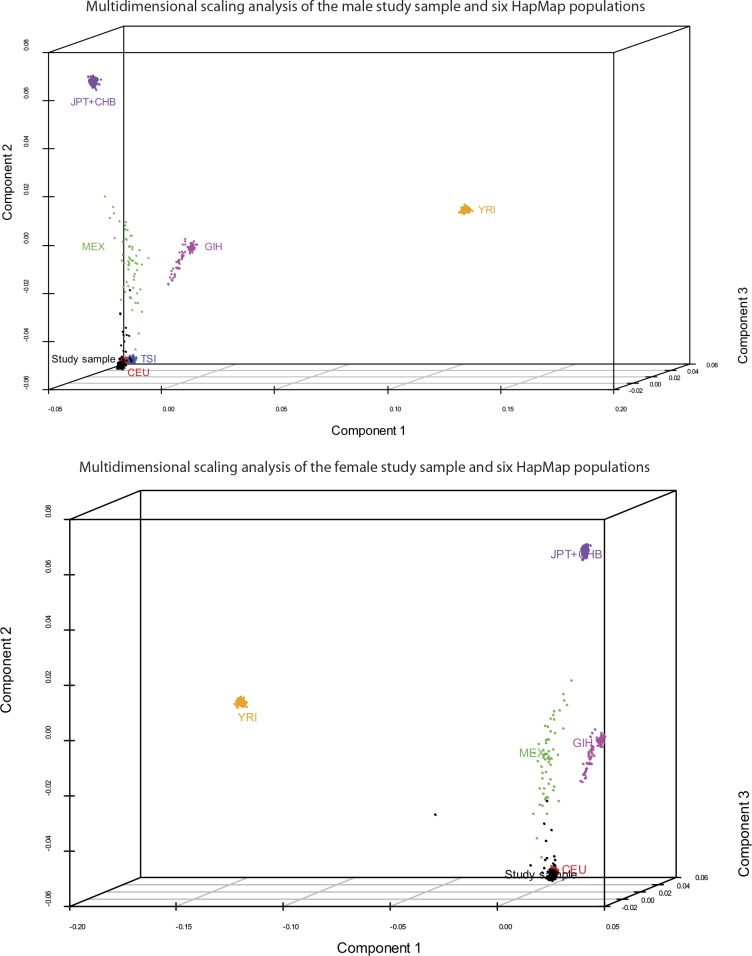
Study samples cluster with the HapMap CEU population.Pairwise identity-by-descent metrics were estimated based on genotype data from our two study samples and six HapMap populations. Multidimensional scaling analysis was performed on the resulting pairwise distances. Components 1–3 of this analysis are plotted for the male (top) and female (bottom) cohorts, and the comparison populations. As expected, the study samples cluster with the HapMap CEU population. 12 outliers were identified in each cohort and were removed prior to analysis.